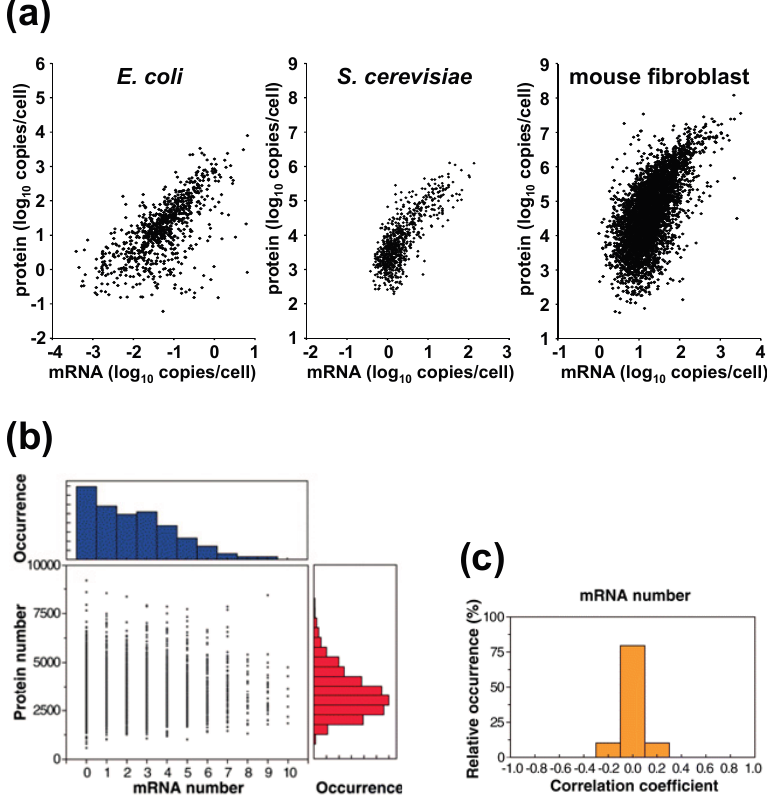
Figure 1. ( a ) Relationship between proteins and mRNA levels across organisms. Data for E. coli , S. cerevisiae , and mouse fibroblast were adapted from references 12, 15, and 14, respectively. ( b ) Correlation plot of mRNA and protein levels of a TufA gene tagged with YFP in single E. coli cells. ( c ) Among the 129 genes that were high copy and analyzed, no correlation was observed between mRNA and protein levels in a single E. coli cell. Data taken from